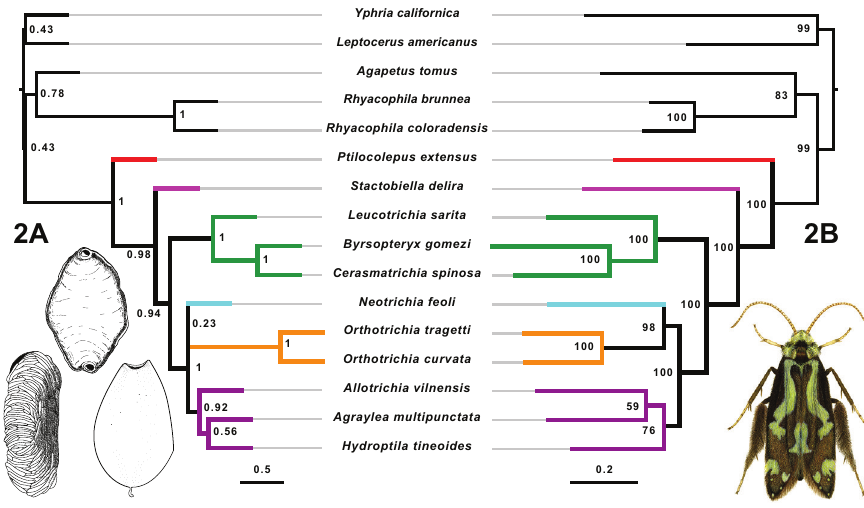
Figure 2. Targeted enrichment data only trees A astral multi-species coalescent tree. Support values are local posterior probabilities. Scale bar: coalescent units. Larval cases: Leucotrichia (top), Dibusa (left), Ithytrichia (right) B maximum-likelihood tree of concatenated supermatrix. Support values are ultra-fast bootstraps estimated in IQ-TREE. Scale bar: substitution rate. Adult: Ascotrichia